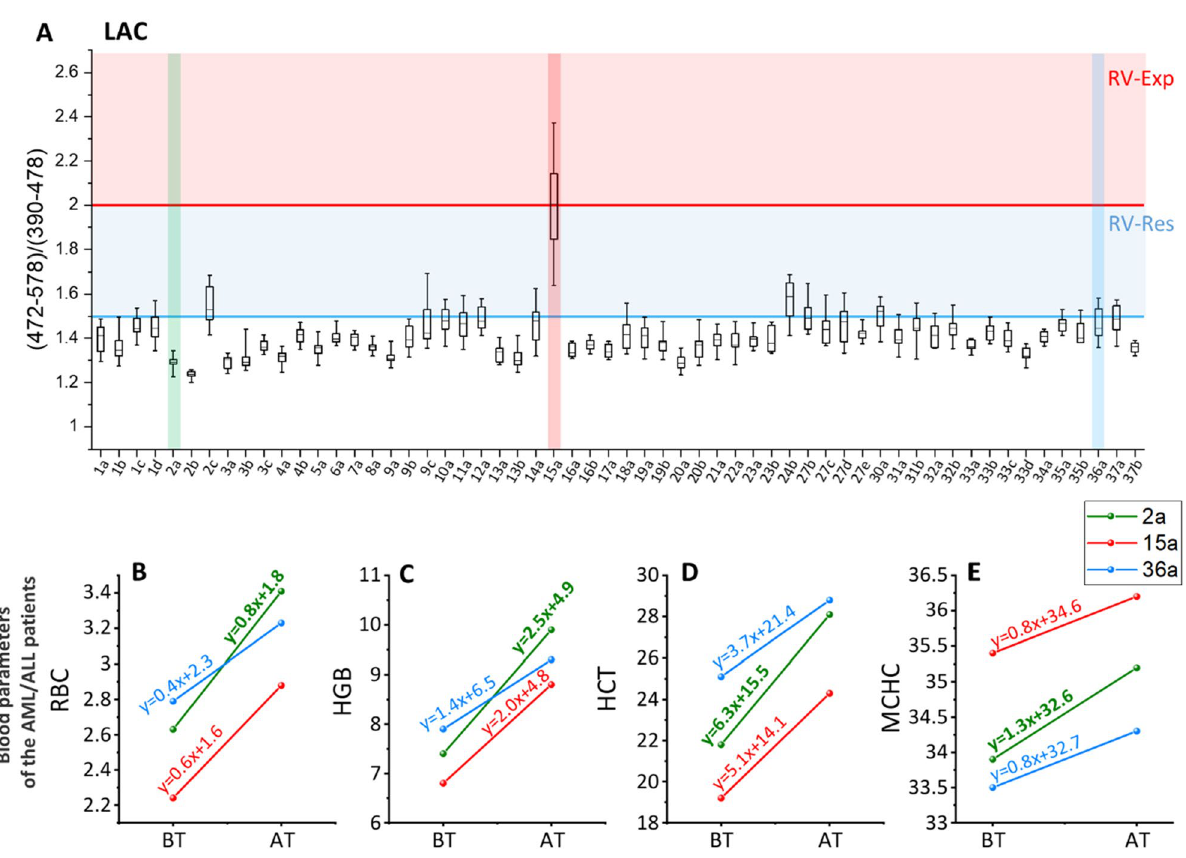
Figure 3. ( A ) LAC ratio values assessed using RS for pRBCs samples validated in clinical environment and intended for blood transfusion (58 transfusions, N = 37; letters a, b, c, d and e represent subsequent blood transfusion given to one patient – 1st, 2nd, 3rd, 4th and 5th respectively). The red region corresponds to pRBCs samples which do not comply the reference value of pRBCs expiration (RV-Exp, red area above RV-Exp line) and should not be considered for blood transfusion even for the healthy patients. The blue region corresponds to samples which do not meet the threshold value of pRBCs quality (RV-Res, blue area above RV-Res line) and can be considered for transfusion, however, should not be intended for transfusion to high-risk patients. Chosen blood parameters of the AML/ALL patients (HGB panel ( B ); HCT panel ( C ) and MCHC panel ( D ) recorded before (BT) and after (AT) the blood transfusion for the chosen samples (2a, 15a and 36a) showing less significant improvement of the blood parameters for the sample which do not meet RV-Res and RV-Exp values (blue and red line, respectively) comparing to the sample with optimal LAC ratio value (green line). The examples were only patients after first blood transfusion (marked with “a”) to eliminate influence of subsequent